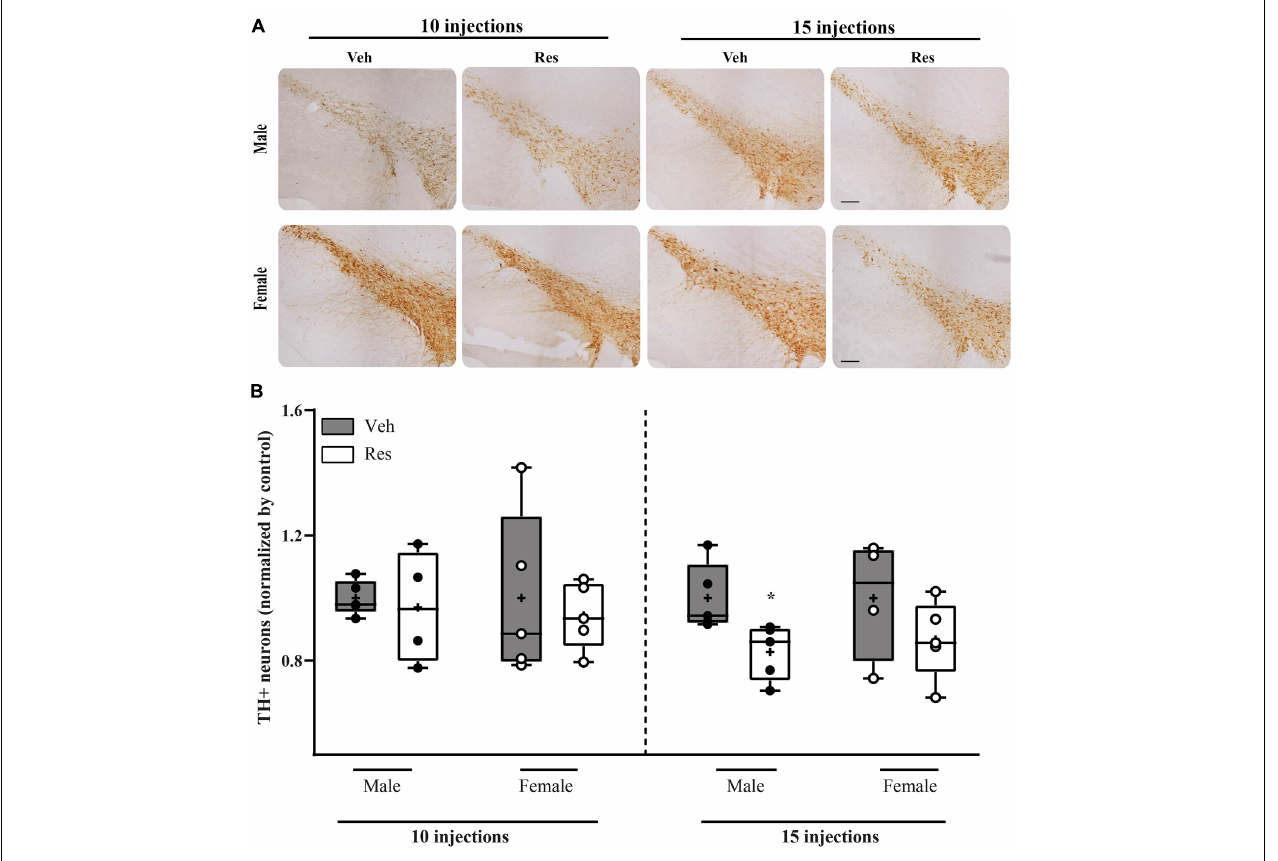
FIGURE 6 | Effects of repeated treatment with 0.1 mg/kg reserpine (Res) or vehicle (Veh) on the number of TH immunoreactive cells in substantia nigra pars compacta in female and male rats after 10 or 15 injections. (A) Representative photomicrographs of brain coronal sections of substantia nigra pars compacta. Scale bar: 100 µ m. (B) Quantification of TH immunoreactive cells. Horizontal lines in the middle of each box indicates the median TH levels, while the top and bottom borders of the box mark the 25th and 75th percentiles, respectively. Black and circles represent individual data of Veh and Res animals, respectively. * p < 0.05 comparing Res and Veh (Mann-Whitney U -test). Data of individual brain sections are displayed in Supplementary Table 3 .